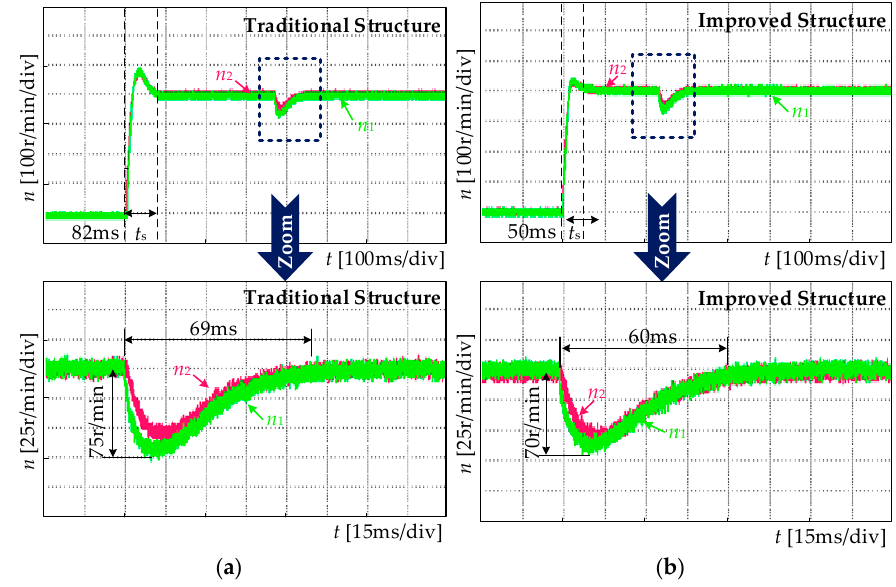
Figure 17. Synchronization error of motors under sudden changes of a load during steady operation: ( a ) Synchronization error in the traditional structure; ( b ) Synchronization error in the improved structure.